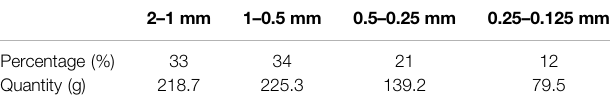
TABLE 5 | Fractions of sieved aggregates (amount per kg of mixture).